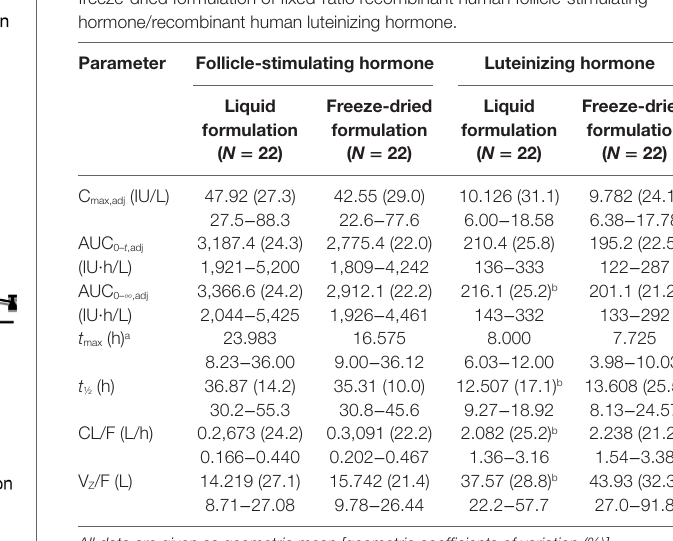
TaBlE 3 | Pharmacokinetic parameters of follicle-stimulating hormone and luteinizing hormone after subcutaneous administration of either the liquid